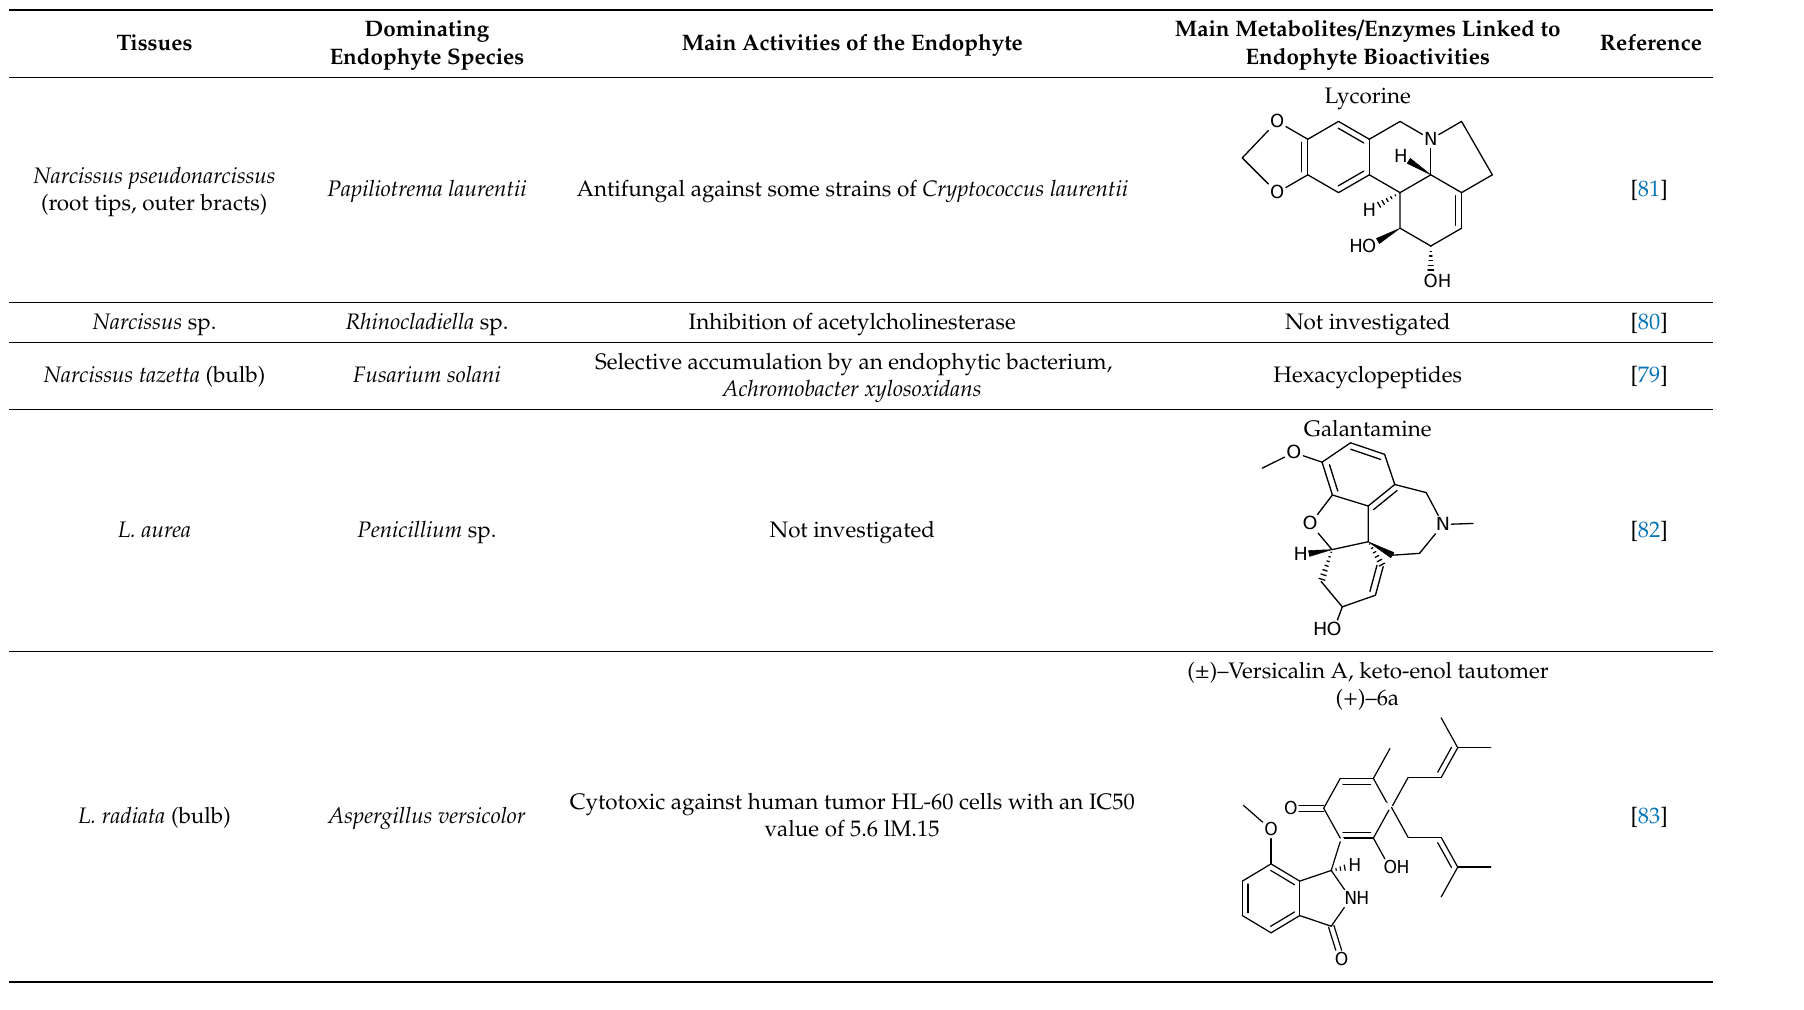
Table 2. Main biological activities of endophytes isolated from Amaryllioidae crops.